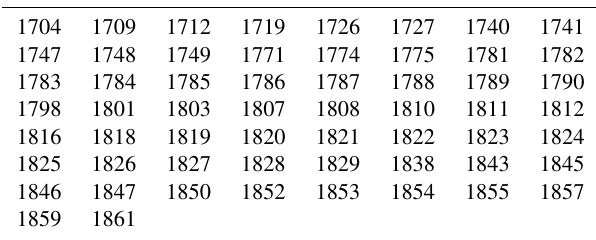
Table B1. Years at or below the 33th percentile of SPEI (drier con- ditions) during the years